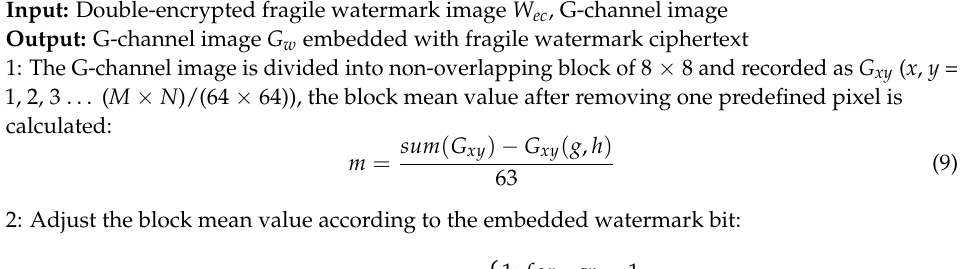
Algorithm 3: Fragile Watermark Embedding